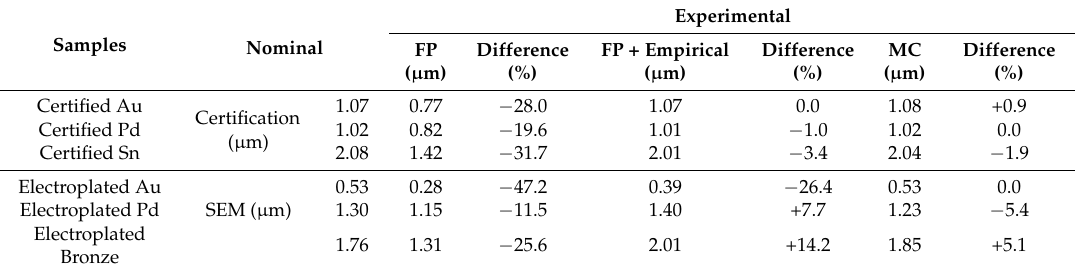
Figure 4. Calibration curves built from the simulations using the pure metals (black) and the composition of the electroplated films (red) of ( a ) Au, ( b ) Pd, and ( c ) Sn. Table 2. Nominal (certified and FIB-SEM) and measured (XRF) thickness calculated with FP and MC methods for the samples.